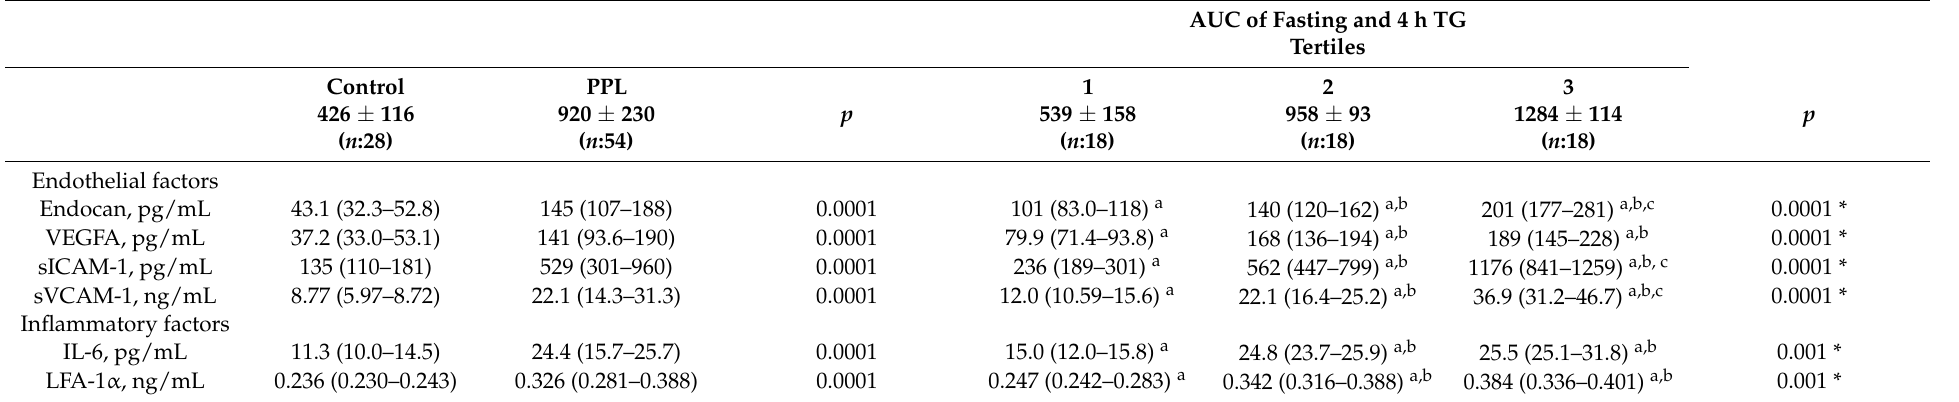
Table 2. Fasting serum levels of endothelial and inflammatory factors in control and PPL tertiles according to AUC, mean ± SD.